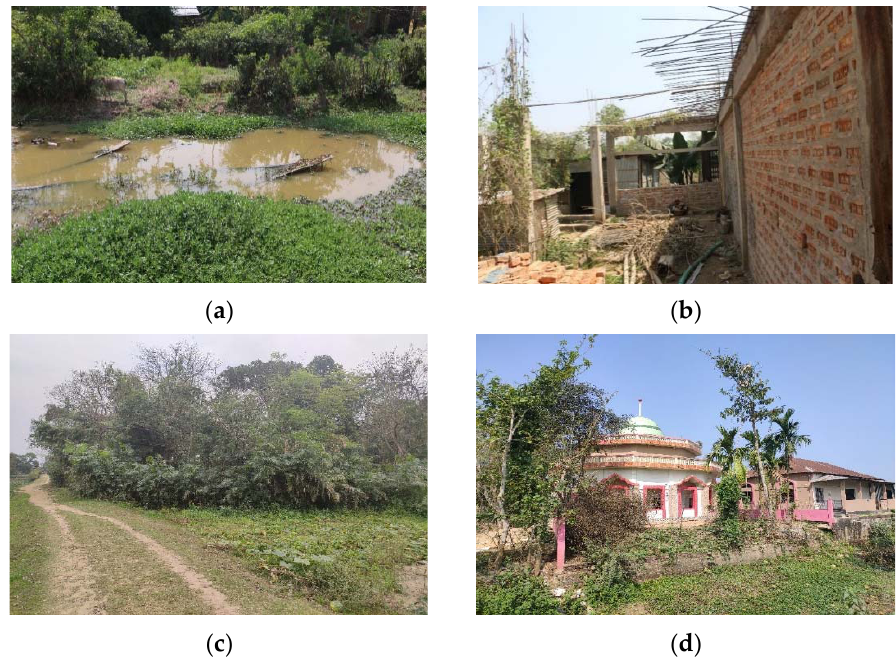
Figure 6. Examples of village environments where human–fishing cat encounters have occurred: ( a ) pond surrounded by vegetation, ( b ) abandoned house, ( c ) road adjacent to bushy patch, ( d ) mosque surrounded by vegetation. Photographs by Eva A. N.